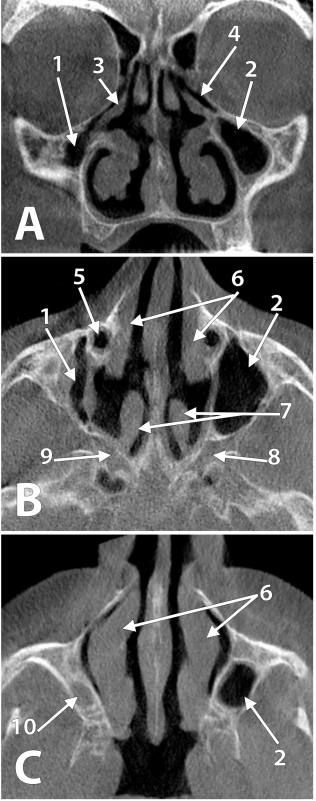
Figure 2. Planar CBCT slices through the hypoplastic maxillary sinuses. ( A ) Coronal slice through the second upper premolar regions; ( B ) axial slice through the roofs of the maxillary sinuses; ( C ) axial slice through the floor of the right maxillary sinus. (1) right maxillary sinus; (2) left maxillary sinus; (3) right uncinate process; (4) left ethmoidal infundibulum; (5) right aerated nasolacrimal duct; (6) inferior nasal turbinates; (7) middle nasal turbinates; (8) left pterygopalatine fossa; (9) right pterygopalatine fossa; (10) floor of the right maxillary